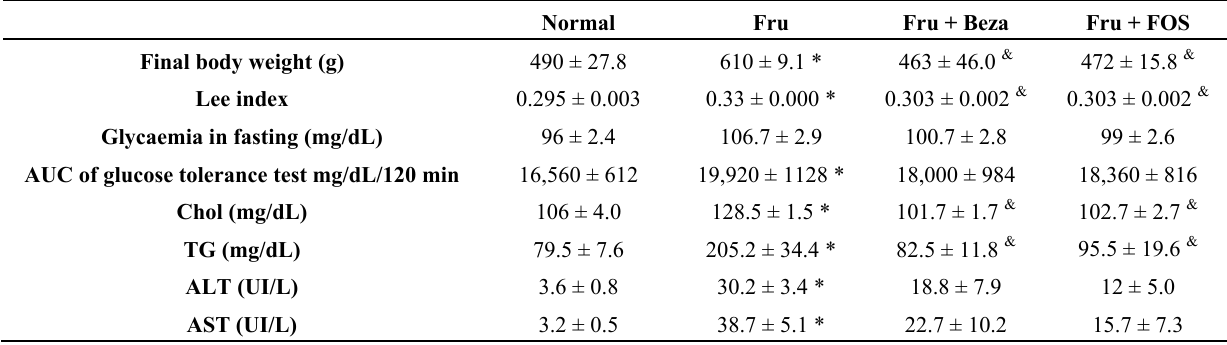
Table 2. Effect of the FOS fraction from P . decompositum on final weight and biochemical parameters in male Wistar rats with 12 weeks of treatment Normal Fru Fru + Beza Fru + FOS Final body weight (g) 490 ± 27.8 610 ± 9.1 * 463 ± 46.0 & 472 ± 15.8 & Lee index 0.295 ± 0.003 0.33 ± 0.000 * 0.303 ± 0.002 & 0.303 ± 0.002 & Glycaemia in fasting (mg/dL) 96 ± 2.4 106.7 ± 2.9 100.7 ± 2.8 99 ± 2.6 AUC of glucose tolerance test mg/dL/120 min 16,560 ± 612 19,920 ± 1128 * 18,000 ± 984 18,360 ± 816 Chol (mg/dL) 106 ± 4.0 128.5 ± 1.5 * 101.7 ± 1.7 & 102.7 ± 2.7 & TG (mg/dL) 79.5 ± 7.6 205.2 ± 34.4 * 82.5 ± 11.8 & 95.5 ± 19.6 & ALT (UI/L) 3.6 ± 0.8 30.2 ± 3.4 * 18.8 ± 7.9 12 ± 5.0 AST (UI/L) 3.2 ± 0.5 38.7 ± 5.1 * 22.7 ± 10.2 15.7 ± 7.3 Mean ± SEM ( n = 6). * Statistically significant compared with the normal group; & statistically significant compared to the group treated with Fru ( p < 0.05); AUC: area under the curve; Normal: normal rats